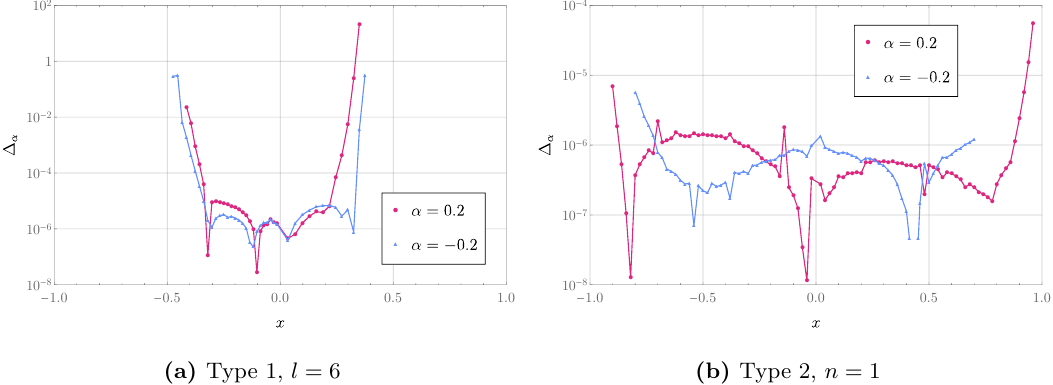
Figure 13 . The relative error ∆ α for α = ± 0 . 2 for two representative deformations, computed with a resolution of N = 60 . Figure (a) shows the Type 1 deformation with l = 6 , while figure (b) shows the Type 2 deformation with n = 1 ; these correspond to the worst- and best-behaved deformations,